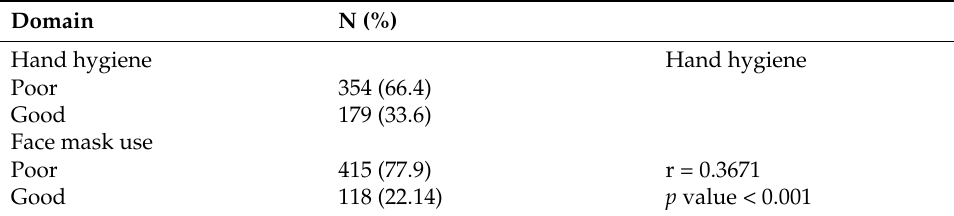
Table 4. Correlation between good hand hygiene and mask use in Mongar Higher Secondary School,